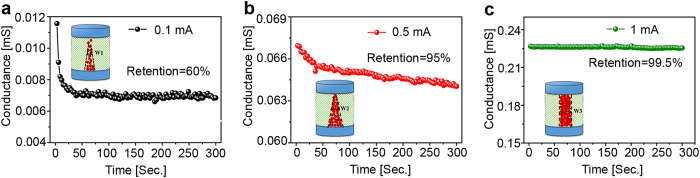
The data stability of FeOx based memristor after electroforming by different Icomp.The resistances read at 0.1 V bias with the duration of 3 seconds for 100 cycles after forming with Icomp of (a) 0.1 mA, (b) 0.5 mA, and (c) 1 mA, respectively.